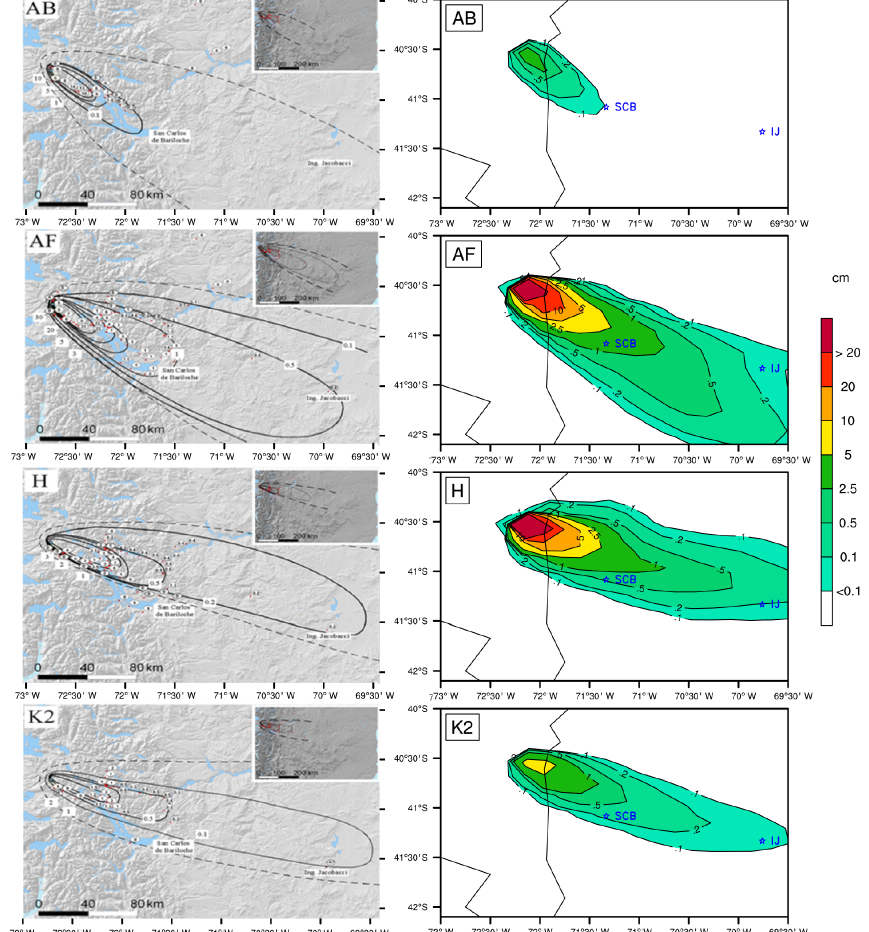
Figure 5. Left panels: isopach maps in centimeter of layers A–B, A–F, H, and K2 from the 2011 Caulle eruption. Dashed lines infer the limit of the deposits presented in Pistolesi et al. (2015). Right panels: corresponding NMMB-MONARCH-ASH computed thicknesses (centime- ters). Key locations in blue include San Carlos de Bariloche (SCB) and Ingeniero Jacobacci (IJ), 90 and 240km east of the